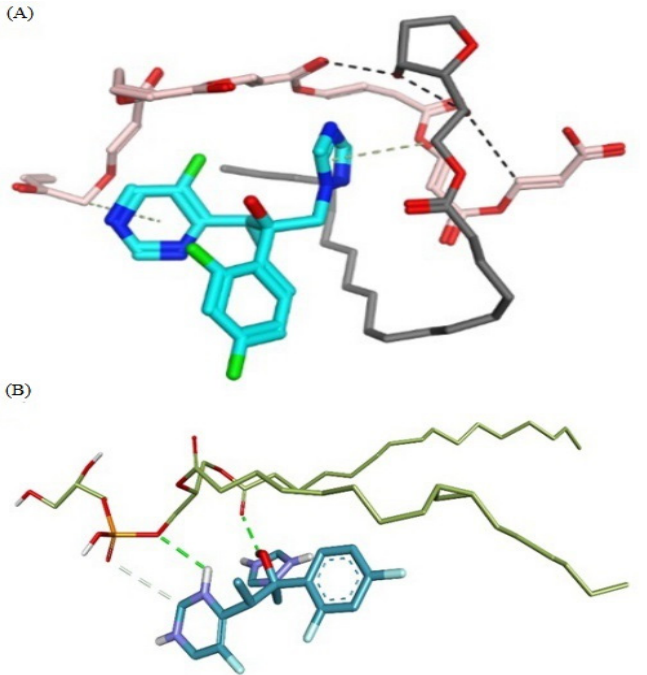
Figure 7. Molecular interactions involved in the stabilization of voriconazole and carbopol. ( A ) The molecular interactions involved in the transethosome stabilization. Voriconazole is presented as cyan carbon sticks while carpobol molecules are presented in pink and grey. ( B ) Green dotted lines show hydrogen bonds, while the light grey dotted lines show π -alkyl interactions.